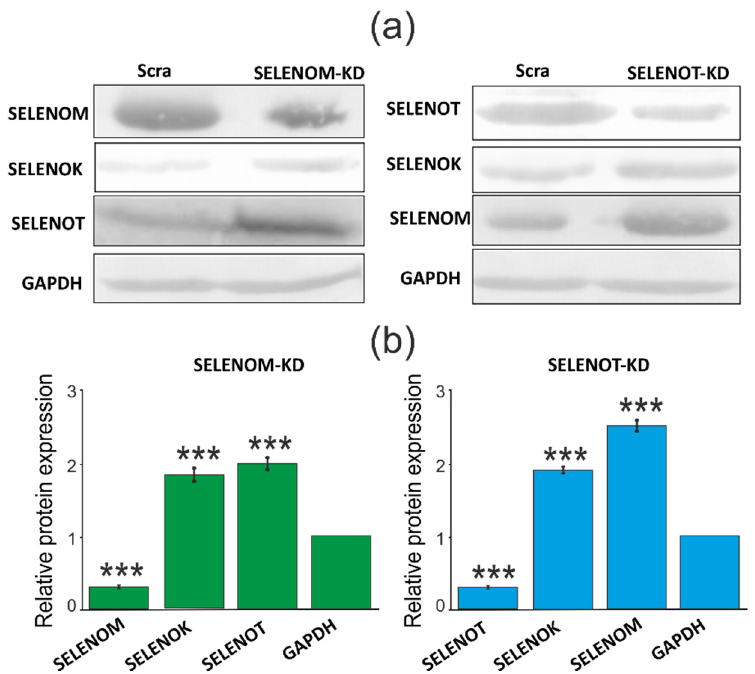
Figure 7. Comparative analysis of the quantitative content of ER resident selenoproteins in samples with SELENOM-KD or SELENOT-KD and control samples, performed using Western blotting ( a ). Quantification of the content of ER resident selenoproteins in A-172 cells transduced with constructs SELENOM-KD (or SELENOT-KD) and scrambled RNA (Scra) ( b ). Comparison of experimental groups regarding GAPDH level: *** p < 0.001.